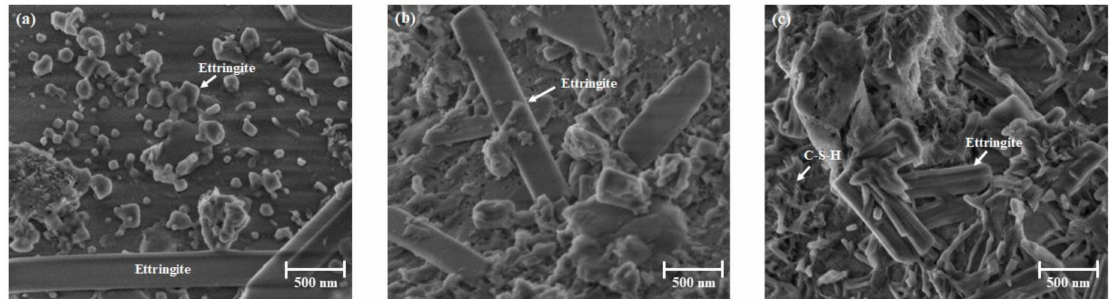
Figure 7. Microstructures of hydrated cement pastes after 15 min at 10 ◦ C ( a ), 20 ◦ C ( b ) and 30 ◦ C ( c ) revealed by SEM.